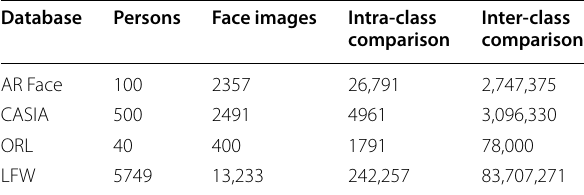
Table 2 Information of the face databases and the comparison number of intra-class and inter-class in the